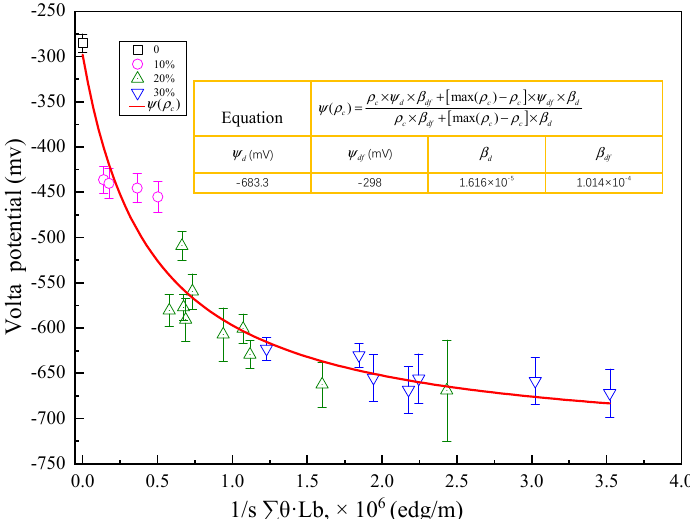
Figure 9. Numerically calculated Volta potential as a function of the dislocation density, the dislo- cation density and Volta potential of different regions of copper cross-sections with different defor- mations were selected for statistics, and the curve represents the fitting result of the formula Ψ ( ρ c ) . Ψ ( ρ c ) is derived from the discussion